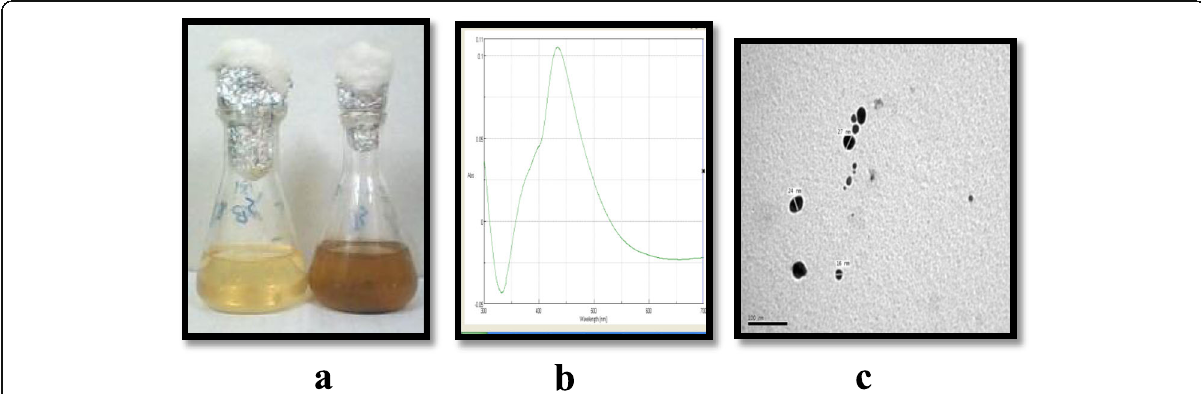
Fig.2 a Conical flasks containing cell-free extract in aqueous solution of 10 − 3 M of AgNo3 for F. oxysporum and the beginning of the reaction (left flask) and after 72 h of reaction (right flask). Formation of AgNPs is detected by color change observation of reaction medium from colorless to yellowness or dark brown. b UV – vis absorbance spectroscopic analysis of the AgNps. c Transmission electron microscopic analysis of the